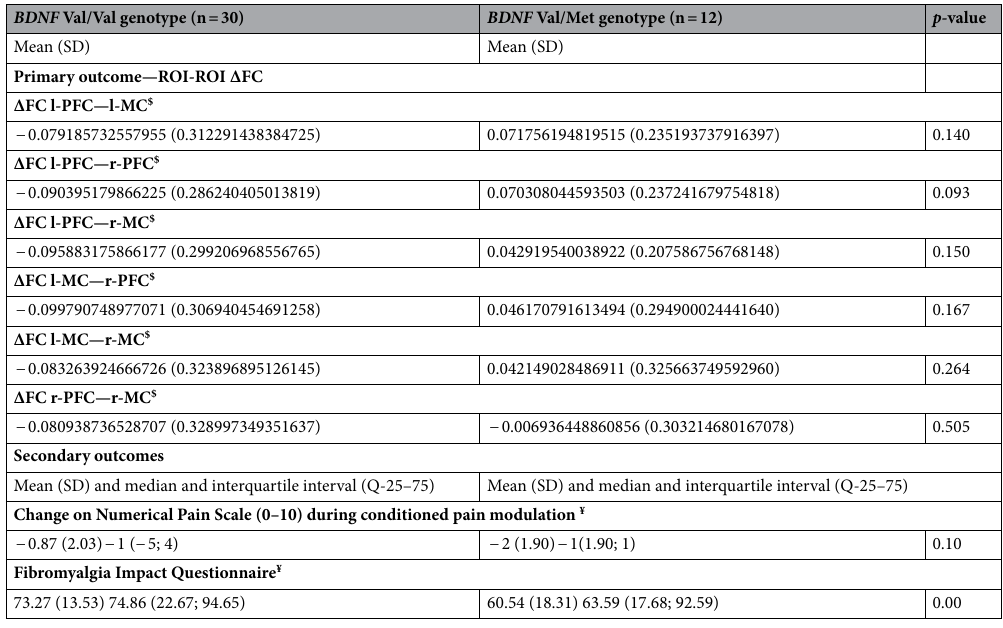
Table 2. Primary and secondary outcomes t-test between BDNF genotype groups (n = 42). Data are presented as the mean (standard deviation) and/or median interquartile. BDNF brain-derived neurotrophic factor . Val/Val Val66Val homozygous . Val/Met Val66Met heterozygous . ROI region of interest . ΔFC difference in functional connectivity . l- left ; r- right . PFC prefrontal cortex. MC motor cortex . SD standard deviation. $ Compared by t-test for independent samples. ¥ Mann–Whitney